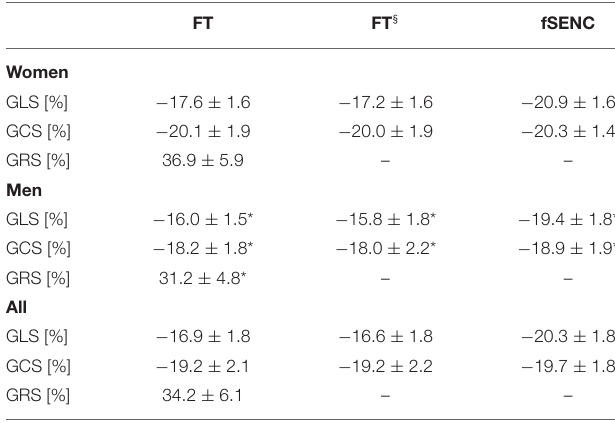
TABLE 2 | Gender-specific global strains values each of FT and fSENC.